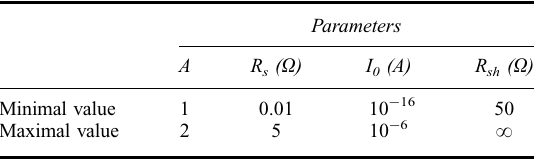
TABLE I Extreme Parameter Values Used for Computing the Ideal Characteristic.